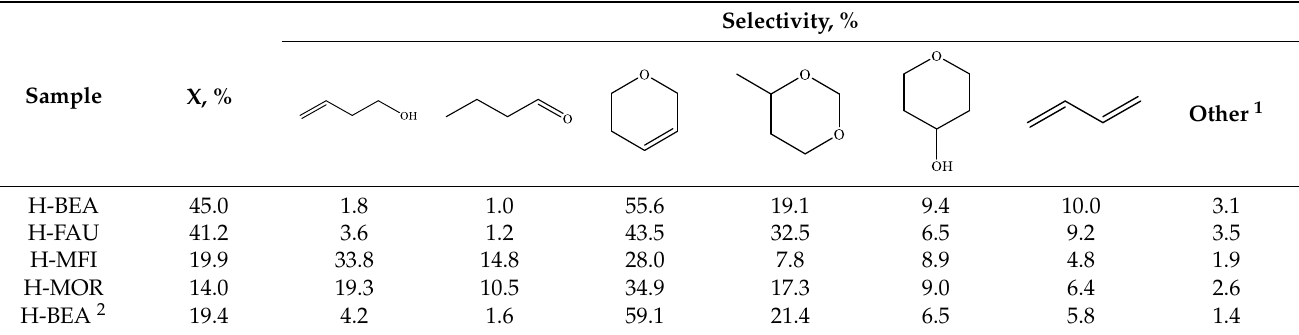
Figure 1. The main reaction network for propylene-formaldehyde condensation. The H-FAU catalyst showed activity similar to H-BEA and selectivity toward buta- 1,3-diene. As in the previous case, the H-FAU produced many side products (summary selectivity about 50%), with low selectivity toward buta-1,3-diene precursors (a summary about 15%); however about 33% of converted formaldehyde was spent on 4-methyl-1,3- dioxane production, thus the H-FAU was concluded to be more suitable for its synthesis and can be used for a two-stage process if its modifications will lead to selectivity growth.